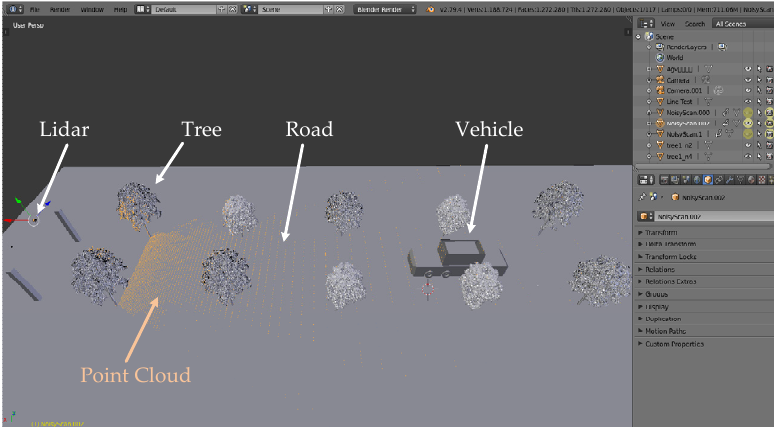
Figure 7. Sketch of the simulation scene and point cloud in BlenSor software (version 1.0.18).